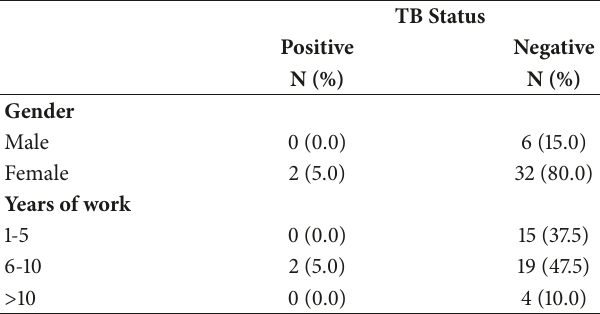
Table 4: Prevalence of TB among participants based on gender and number of years of charcoal production.